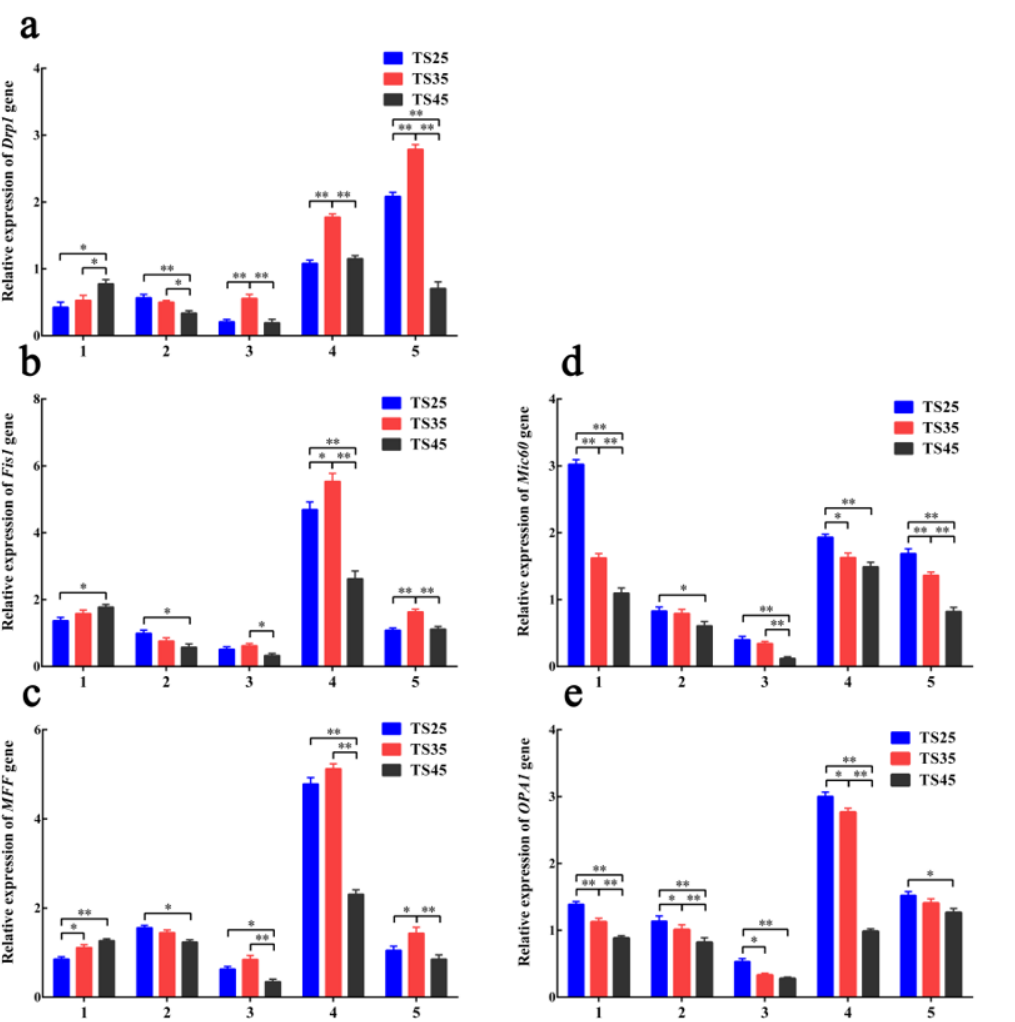
Figure 6. The expression of mitochondria fission ( Drp1 ( a ), Fis1 ( b ), MFF ( c )) and fusion ( Mic60 ( d ), OPA1 ( e )) genes in five tissues of Tibetan sheep. ( 1 – 5 ) Heart, liver, lung, brain, quadriceps femoris. ( TS25 ) 2500 m altitude Tibetan sheep. ( TS35 ) 3500 m altitude Tibetan sheep. ( TS45 ) 4500 m altitude Tibetan sheep. Date shown on graph are means ± SEM. * p < 0.05, ** p < 0.01.